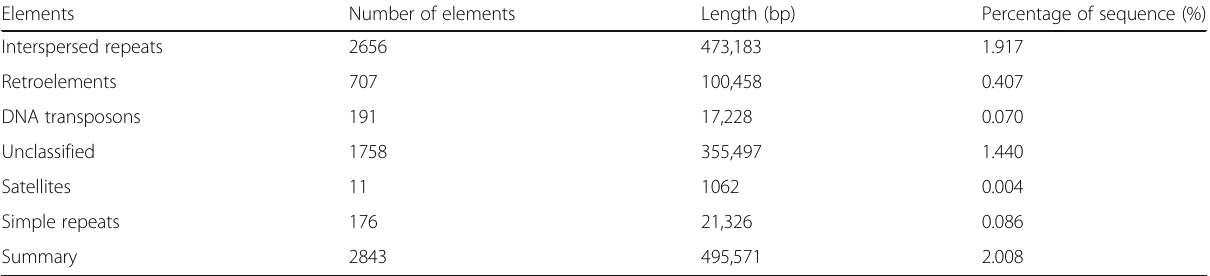
Table 3 Statistic summary of repeat sequence of Plasmodiophora brassicae strain ZJ-1 genome